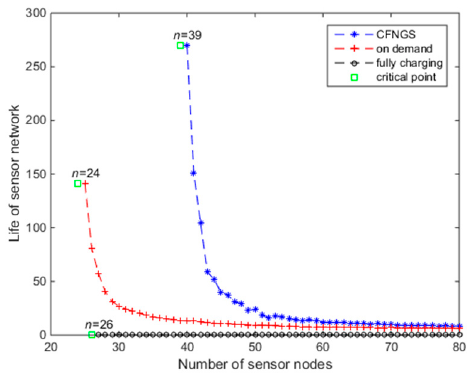
Figure 8. Lifetime of network changes with n.